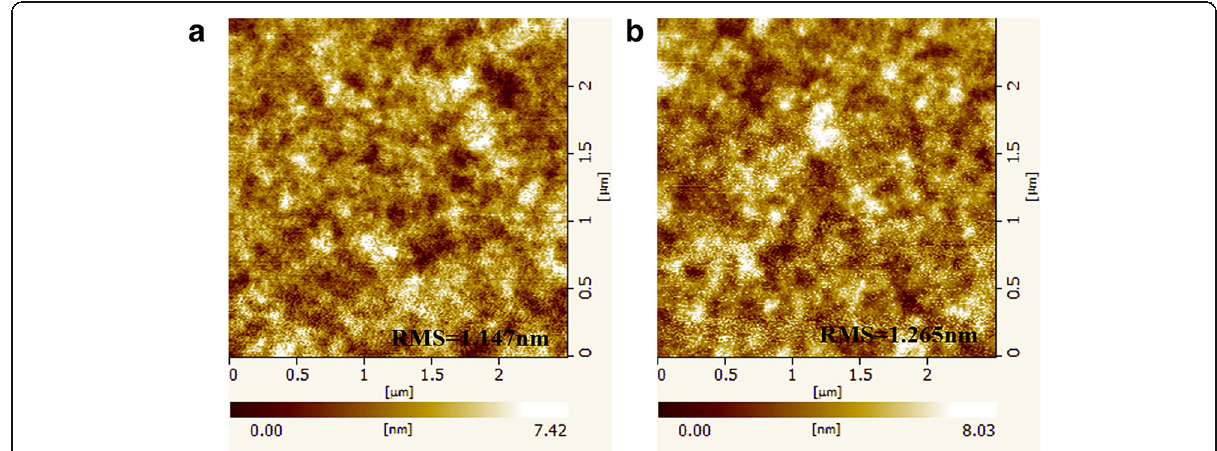
Fig. 4 AFM top-view images of a pristine PEDOT:PSS and b rGO/PEDOT:PSS thin films: all images captured an area of 2.5 × 2.5 μ m